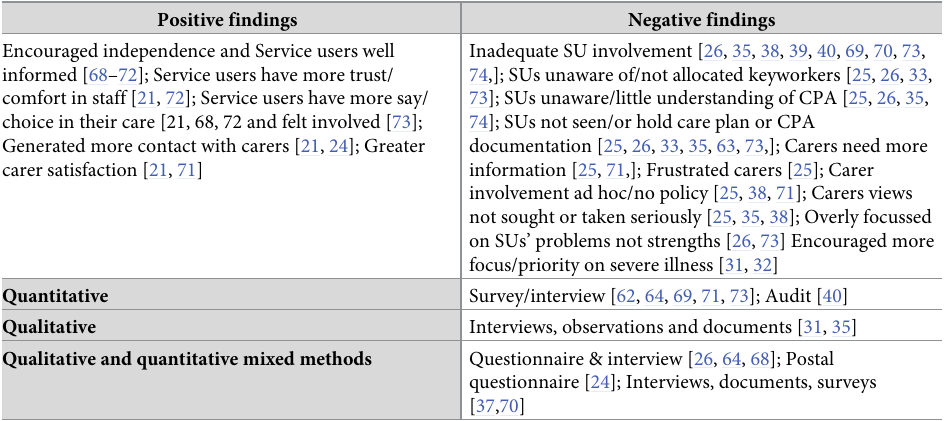
Table 5. Tradition 3: Service users’ and carers’ experiences and involvement in CPA. Positive findings Negative